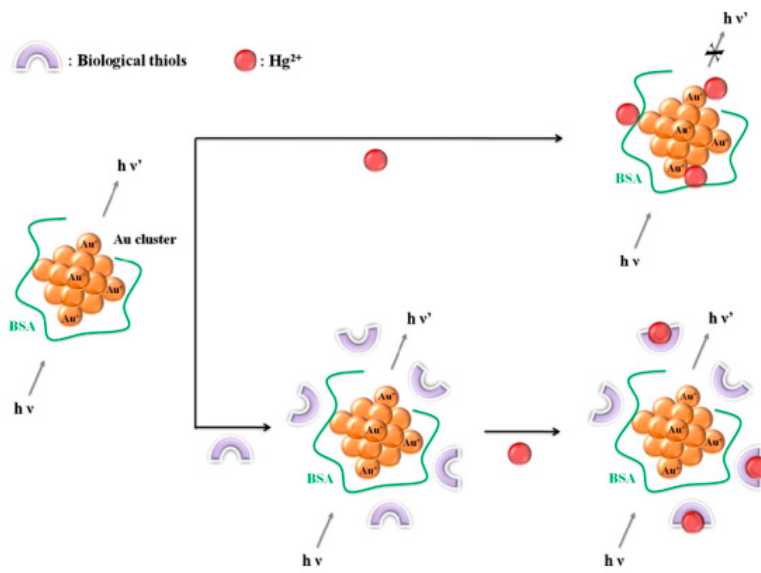
Figure 3. Schematic illustration of the biological thiol detection system based on the prevention against Hg 2+ -induced quenching of fluorescent gold nanoclusters (AuNCs). Adapted with permission from Reference [57] Copyright (2013) Elsevier.